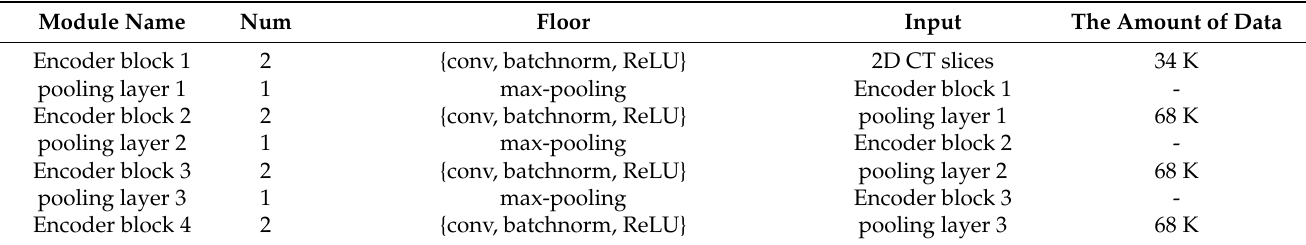
Table 1. Encoder-Decoder Network